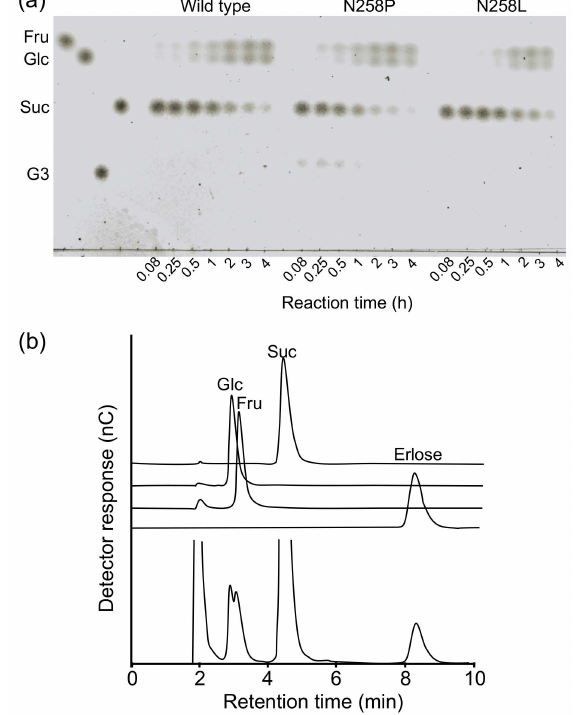
Figure 3. Analysis of the reaction products from sucrose. ( a ) TLC analysis of the reaction prod- ucts from sucrose by wild type, N258P, and N258L. The reaction time is shown below the figure. ( b ) HPAEC-PAD analysis of the reaction products produced by N258P after a 30 min reaction. 2.4. Structural Analysis of BspAG13_31A E256Q/N258G and